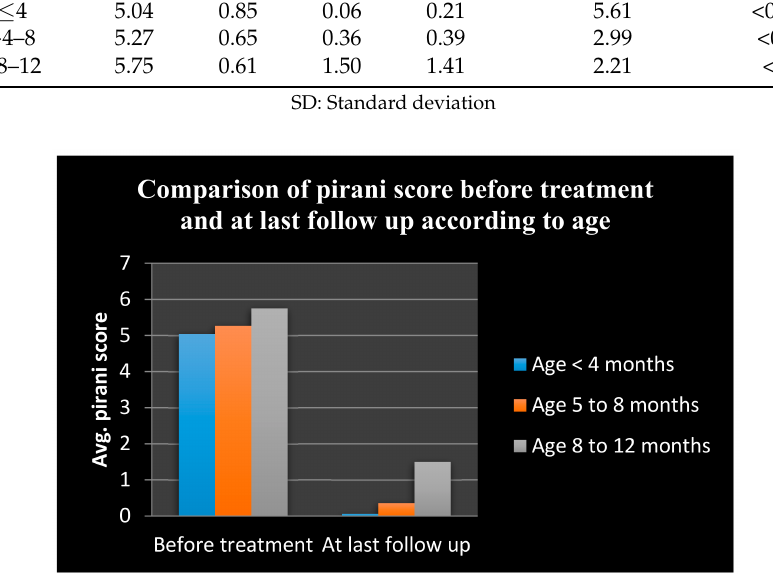
Figure 9. Bar diagram for Pirani score